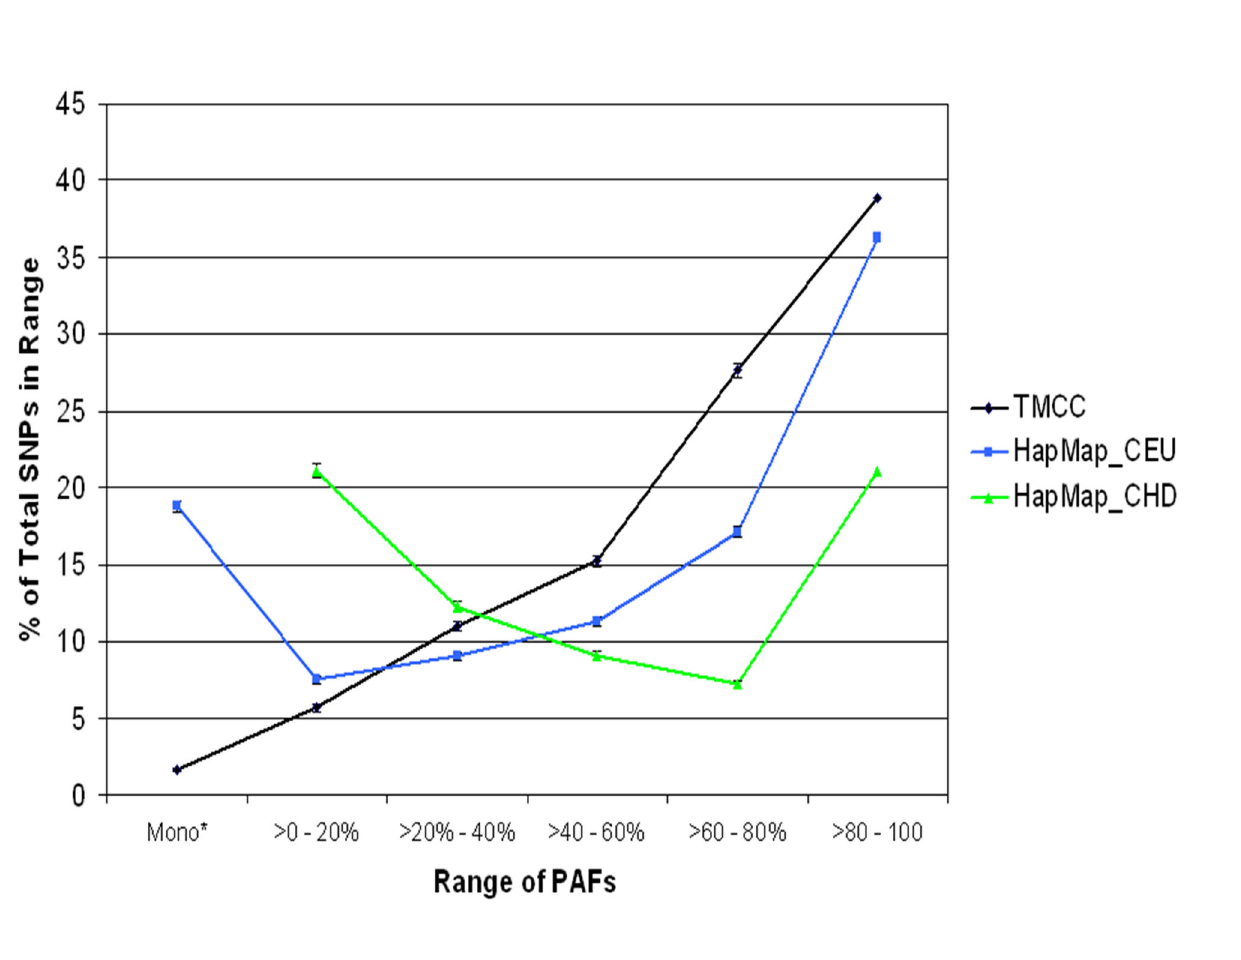
Figure 1. The proportion of PAFs in ranges for TMCC and HapMap